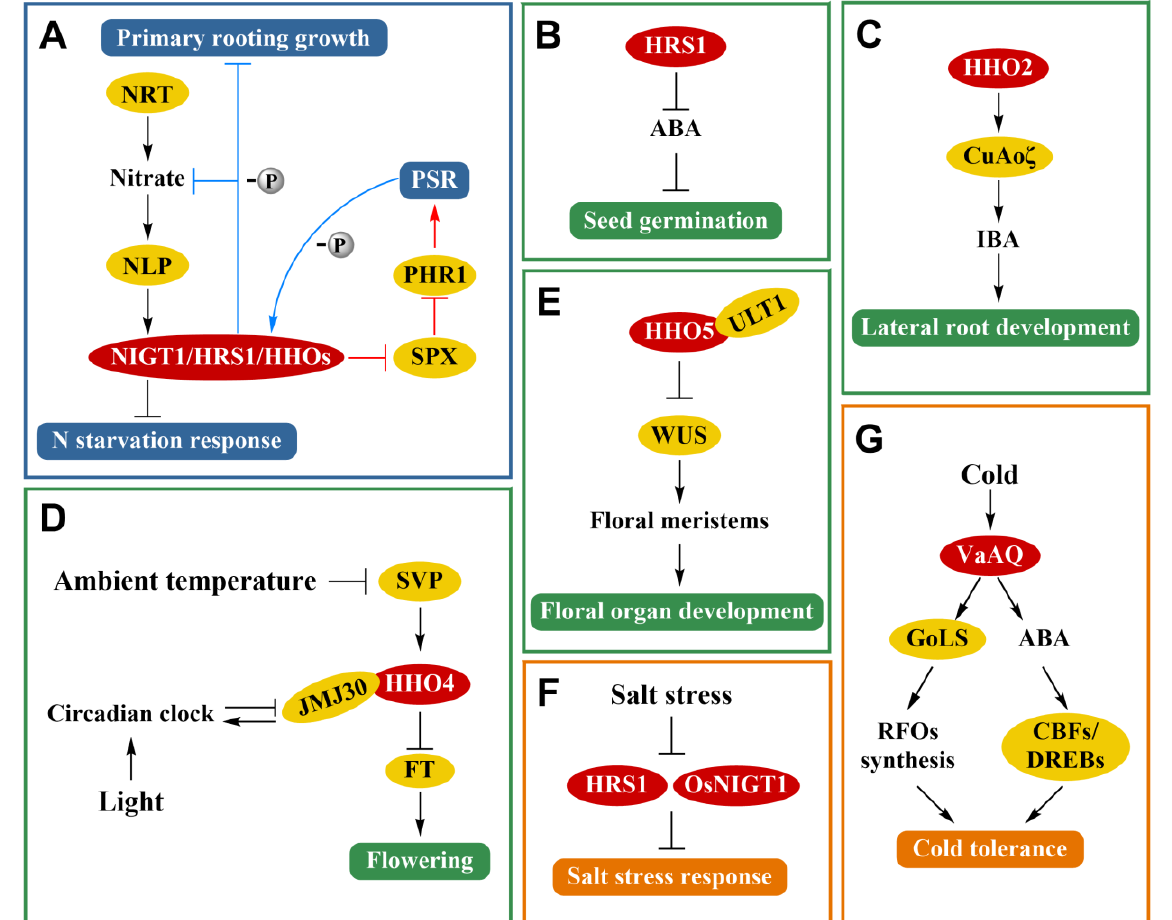
Figure 2. Simplified schematic of NIGT1/HRS1/HHO TFs involved in multifunctional regulation in plants. ( A ) The black arrow: Nitrate transporter NRT can increase the content of nitrate and can enhance the expression of the nitrate response transcription factors and induce the expression of NIGT1/HRS1/HHO family genes to inhibit the N starvation response. The red arrow: NIGT1/HRS1/HHO TFs can inhibit the expression of SPX and can induce the expression of PHR1 to promote PSR. The blue arrow: Under Pi deficiency, PSR can promote the expression of NIGT1/HRS1/HHO TFs to inhibit nitrate absorption and primary root growth. ( B – E ) Functions of NIGT1/HRS1/HHO TFs in plant growth and development. ( B ) HRS1 can promote seed germination by inhibiting ABA signaling. ( C ) HHO2 can increase the expression of CuAOζ and promotes IBA to enhance lateral root growth. ( D ) NIGT1/HRS1/HHO TFs are involved in flowering by coordinating temperature and light. SVP can promote the expression of HHO4 . HHO4 can interact with JMJ30. Protein complex of HHO4 and JMJ30 repress the expression of FT gene to inhibit flowering. ( E ) HHO5 can interact with ULT1 and can inhibit the expression of WUS to participate in the homeostasis of floral meristems and the growth and development of floral organs. ( F , G ) Functions of NIGT1/HRS1/HHO TFs in abiotic stress. ( F ) The expression of HRS1 and OsNIGT1 are repressed under salt stress. Mutants of HRS1 and OsNIGT1 can enhance tolerance to salt stress. ( G ) VaAQ can improve low temperature tolerance. VaAQ increased the synthesis of RFOs by increasing GoLS activity to improve low temperature tolerance. VaAQ also regulates the expression of the CBFs or DREBs and improves tolerance to low temperature stress through the ABA pathway. Promoting and repressive effects are indicated by → and ┤ , respectively, and P deficiency is denoted by - P.